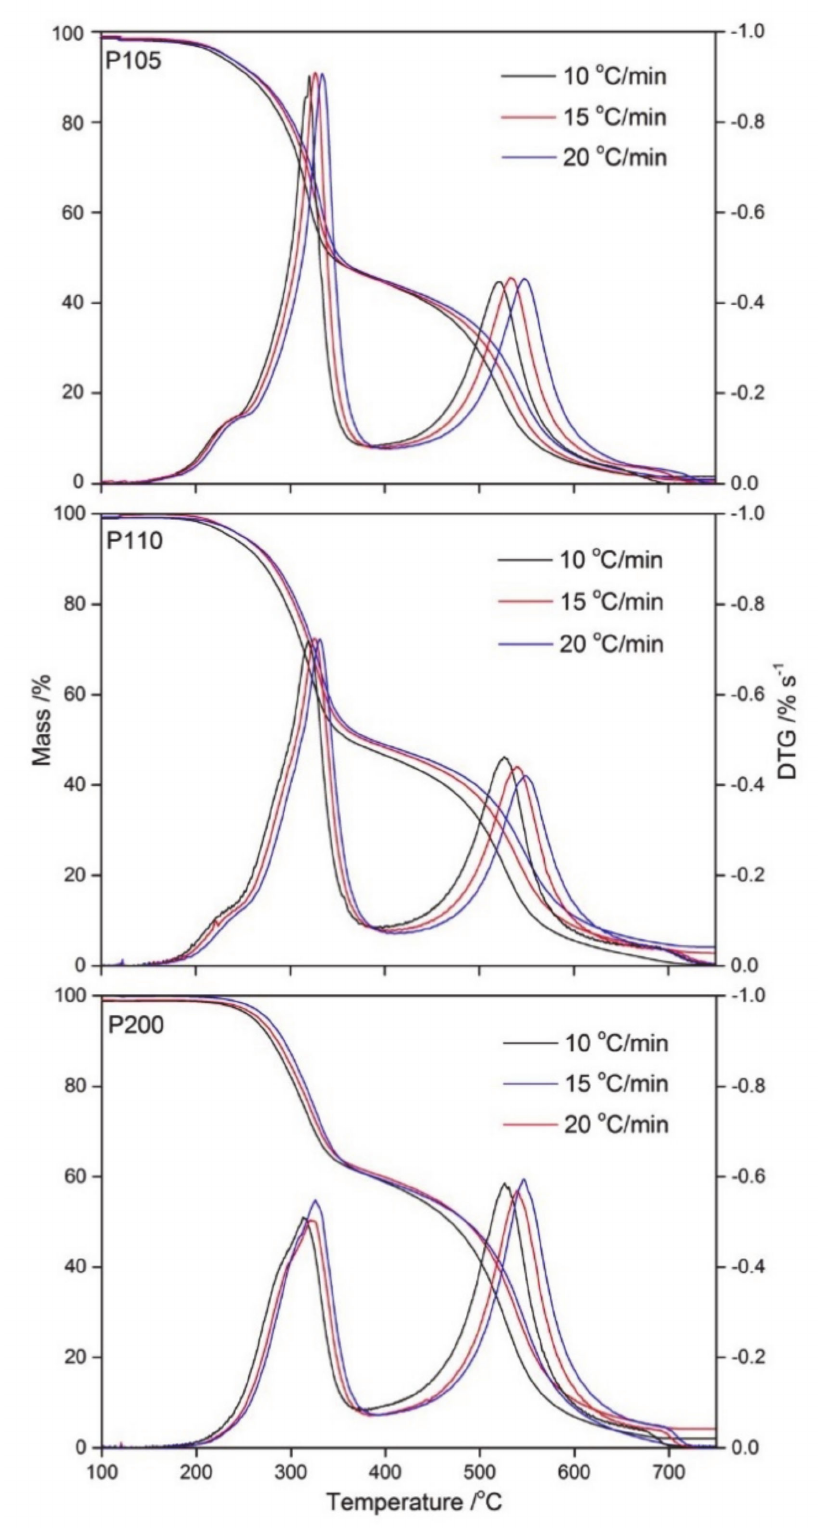
Figure 1. TG and DTG curves of P105, 110, and 200 in the air at 10, 15, and 20 ◦ C min − 1